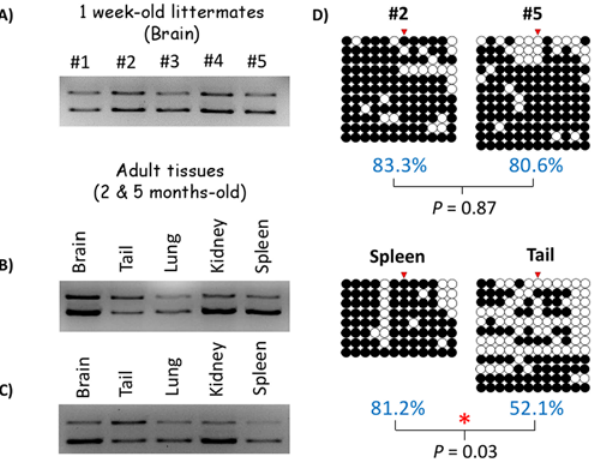
Fig 4. Variable levels of DNA methylation of the P1 promoter among neonates and adult organs. The DNA methylation levels of the P1 promoter were analyzed using the first set of DNA derived from one-week- old littermates (A), the second and third sets from the various organs of two- (B) and five-month-old individual mice of C57BL/6J (C). The PCR products amplified from the bisulfite-converted DNA were digested with Taq I enzyme to survey the methylation levels. The upper and lower bands indicate the undigested and digested, thus unmethylated and methylated DNA fragments, respectively. Two samples (#2 and #5) from the first set (one-week-old littermates) and two additional samples (Spleen and Tail) from the third set (five-month-old mice) were further analyzed through cloning and sequencing (D). The methylation levels are presented along with the P -values from Mann-Whitney U test measuring statistical